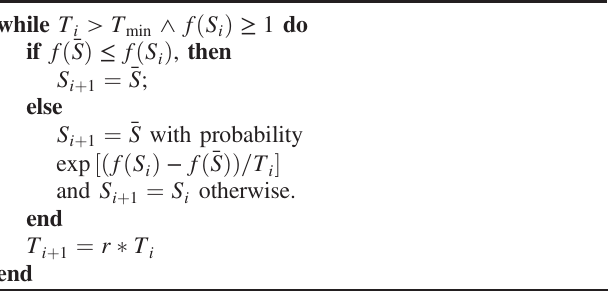
Algorithm 1: Simulated annealing.